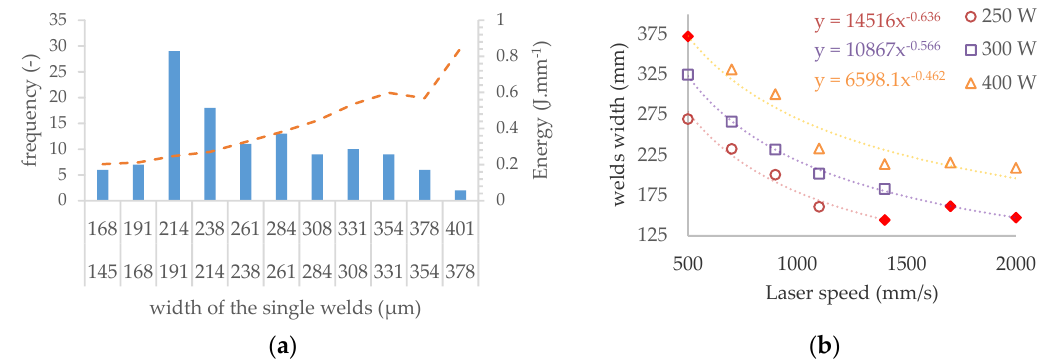
Figure 8. The results of the single welds test ( a ) histogram of the width frequency of single welds, ( b ) the prediction of weld width for non-tested combinations of process parameters.